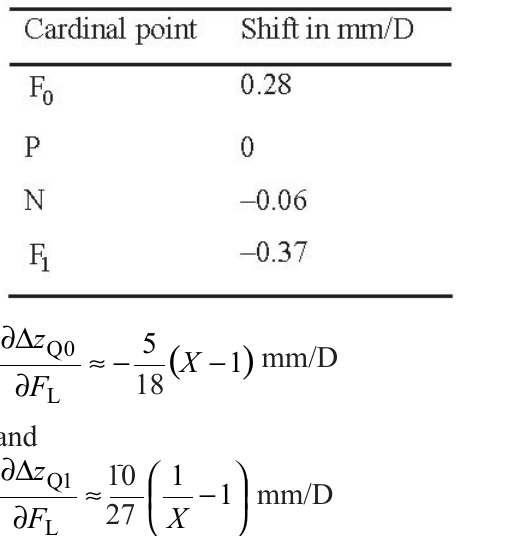
Table 2 Approximate shifts in location of the cardinal points caused by a contact lens on a reduced eye.